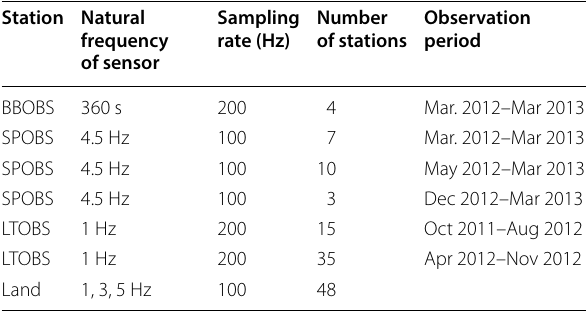
and observational